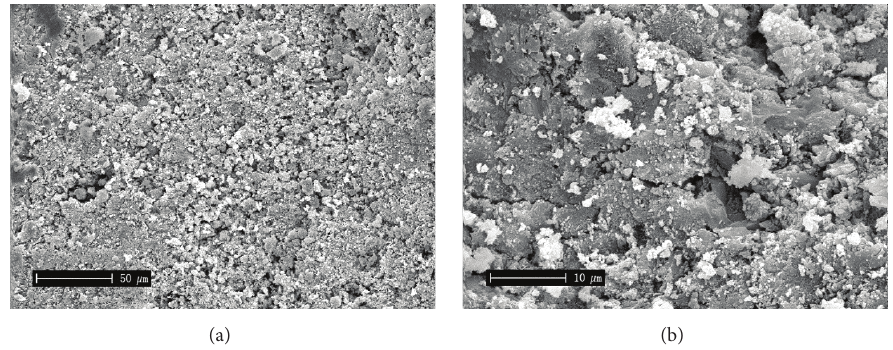
Figure 6: SEM images of microstructure of PC exposed at 300 ∘ C for 2.5 h at (a) 1000x and (b) 5000x magnification.